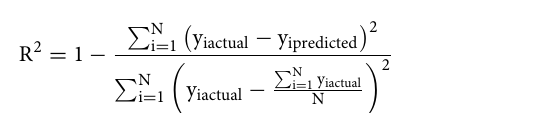
Figure 2. Scatter matrix plot of data features. Blue dots for the training dataset, orange dots for the testing dataset, and green dots for the validation dataset. The diagonal charts show the distribution of each